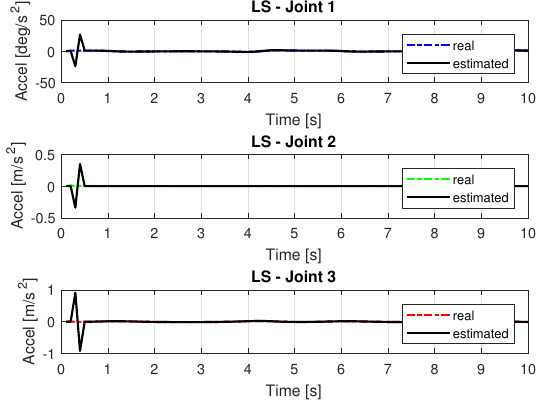
Figure 9. Accelerations of joints with LS.